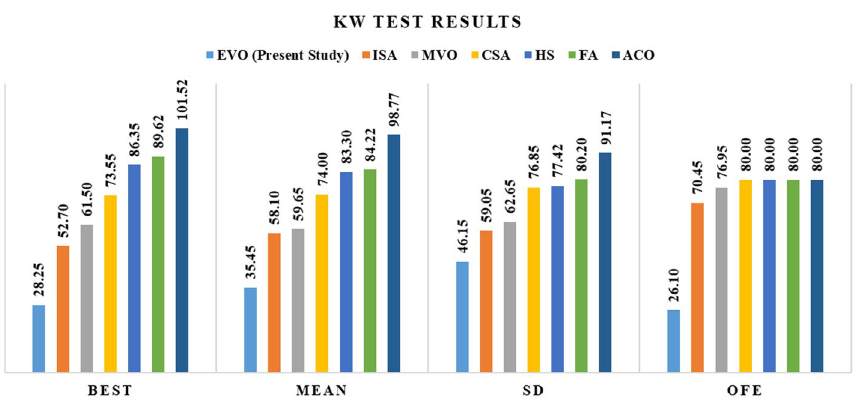
Figure 7. The KW test results including mean of the ranks for different metaheuristic algorithms.